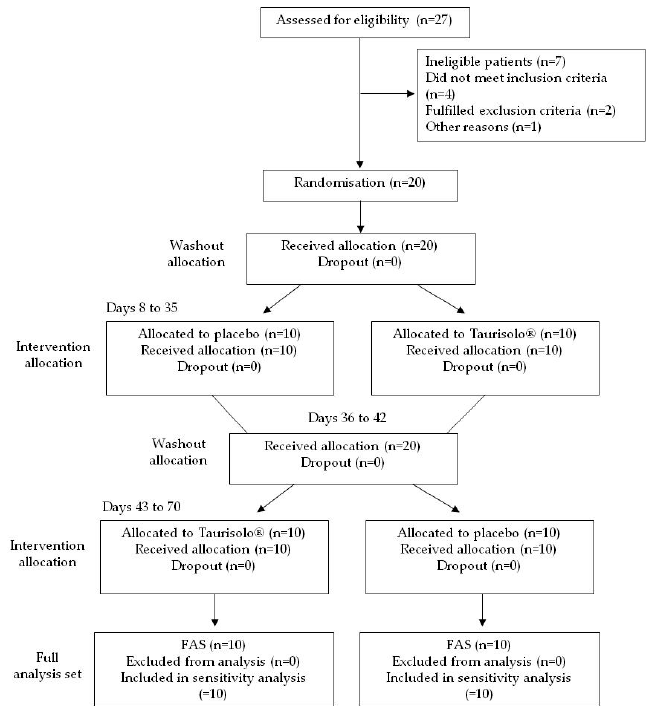
Figure 3. Study flowchart. Study flowchart, according to the consolidated standards of reporting trials (CONSORT). The diagram shows enrolment and primary efficacy endpoints based on patients’ diaries, from prescreening to data collection; and the extent of exclusions, loss to follow-up, and completeness of. Diary documentation available across the entire trial period. FAS, Full analysis set.